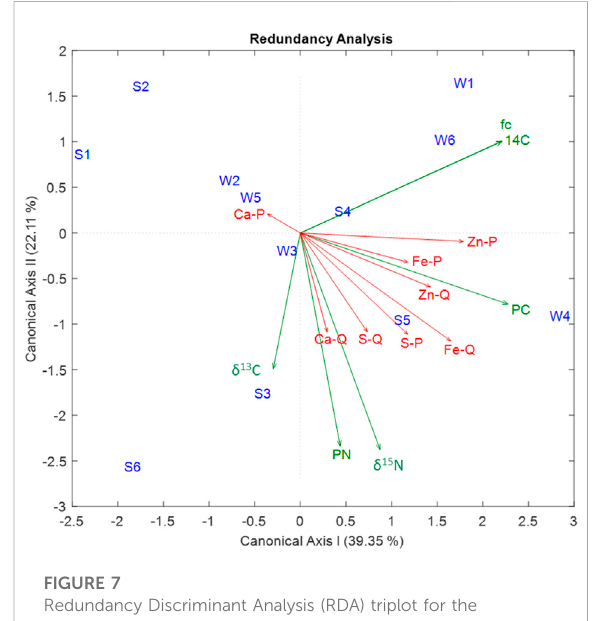
FIGURE 7 Redundancy Discriminant Analysis (RDA) triplot for the 6 winter (W) and 6 spring-summer (S) samples reported in blue. The input variables are the Ca, Fe, S, and Zn concentrations determined by PIXE using both PTFE (P) and quartz (Q) fi lters as predictive variables (red arrows) and the stable isotope measurements of nitrogen and carbon ( δ 15 N and δ 13 C, respectively), particulate nitrogen and carbon content(PN and PC, respectively),amountof 14 Cexpressedinaunitofpercent modern carbon (pMC), and the contemporary carbon fraction f c (%) as response variables (green arrows). The total variance explained by the two RDA axes is also reported in